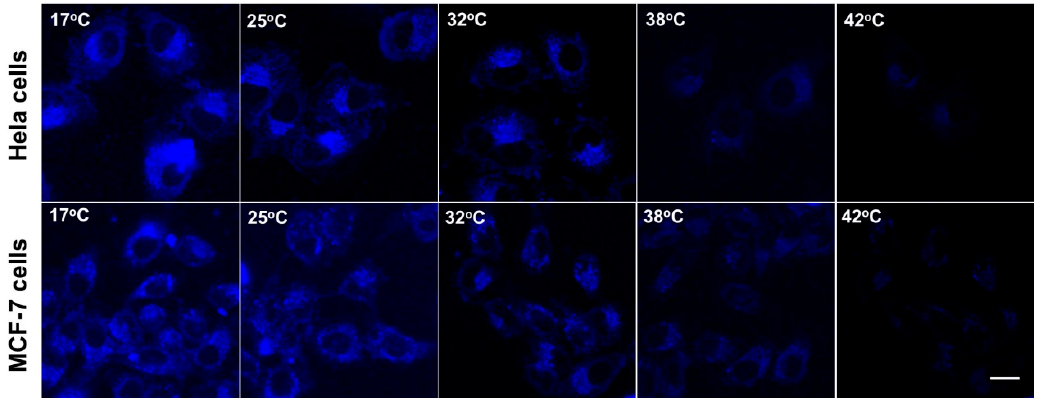
Figure 5. Confocal fluorescence imaging of Hela cells and MCF-7 cells after being stained with Si NCs-FA-PNIPAAm (the scale bar is 20 μ m).